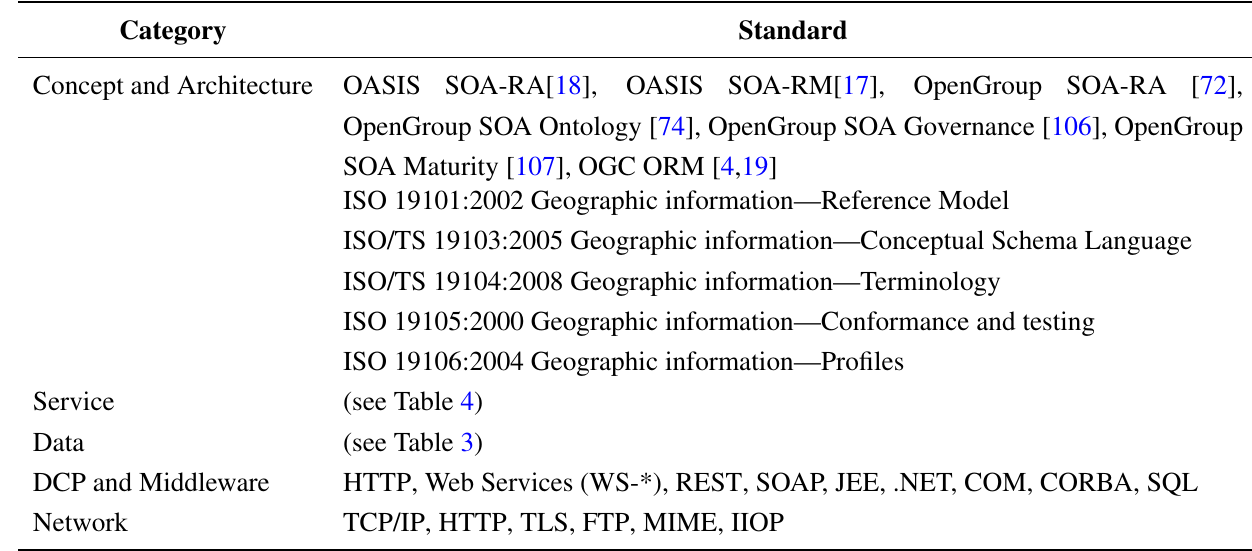
Table 2. Overview of the technology standards stack relevant for 3DGeoVSs based on service-oriented architectures, standards and image-based representations (SSI). OASIS, Organization for the Advancement of Structured Information Standards; OGC, Open Geospatial Consortium; DCP, distributed computing platform; JEE, Java Enterprise Edition; COM, Component Object Model; CORBA, Common Object Request Broker Architecture; TLS, Transport Layer Security; IIOP, Internet Inter-Object Request Broker